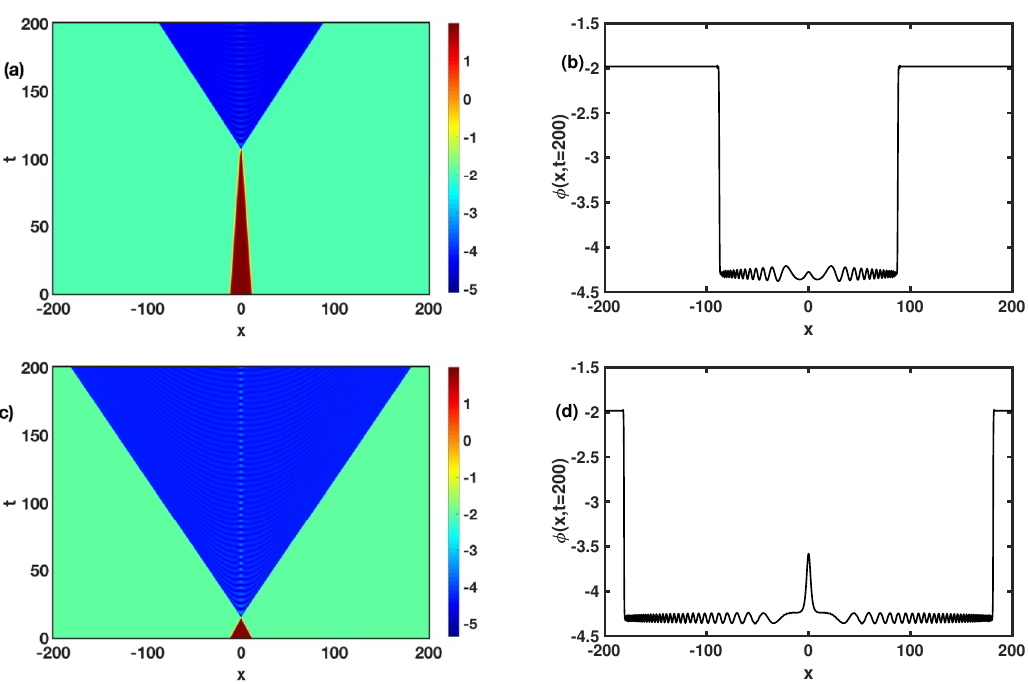
Figure 6 . Large kink-antikink collision (left) and image of last simulation time of scalar field as a function of x (right) for a) b) v = 0 . 1 and c) d) v = 0 . 8. In all figures we fixed r = 0 . 4. Note the presence of the confined oscillation for v = 0 .